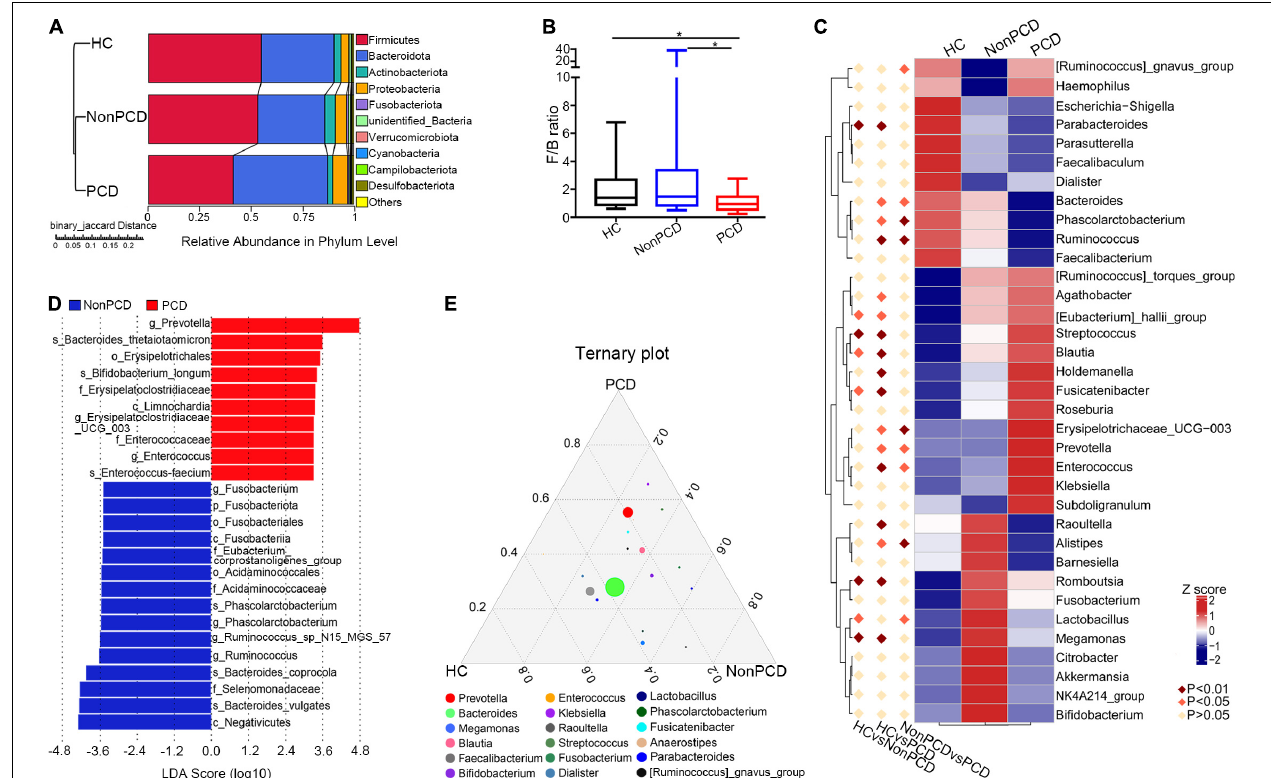
FIGURE 3 | Identification of altered bacterial taxa involved in PCD patients. (A) Grouped unweighted pair-group method with arithmetic means (UPGMA) tree based on binary-Jaccard distance showing microbial similarity among groups (left panel) and relative abundance of top 10 bacteria in phylum level (right panel). (B) Decreased Firmicutes / Bacteroidota ratio in the PCD group, compared to Non-PCD and HC groups. Data are presented in box plot as Min to Max; n = 22 for HC, 25 for Non-PCD, and 23 for PCD patients. * p < 0.05. (C) Representative heatmap analyzed by MetaStat method showing microbial differences in genus level among three groups. (D) Linear discriminant analysis (LDA) effect size (LEfSe) was applied to identify differential abundance of genera in Non-PCD and PCD groups (bacteria whose LDA score > 3.0 were plotted). (E) Ternary plot showing differential microbial genera in these groups; the three vertexes of this graph were denoted HC, Non-PCD, and PCD, respectively. Different dots represent corresponding genera and the size for relative abundance of microbe. The closer to vertexes, the greater contribution to groups.